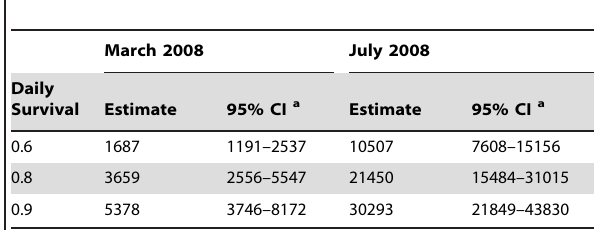
Table 3. Estimated population sizes for Fourda using the joint hypergeometric maximum likelihood estimator from the program NOREMARK for varying daily survival rates.